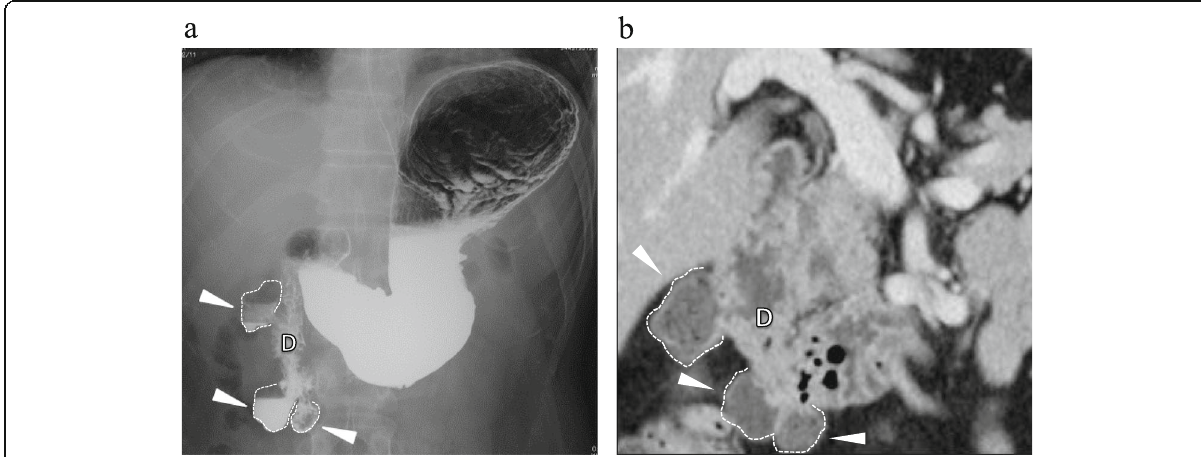
Fig. 3 An upper gastrointestinal series and a contrast-enhanced CT of case 2 before gastrectomy. Multiple non-ampullary duodenal diverticula (white arrowhead) were detected at the second and third parts of the duodenum (D) ( a , b